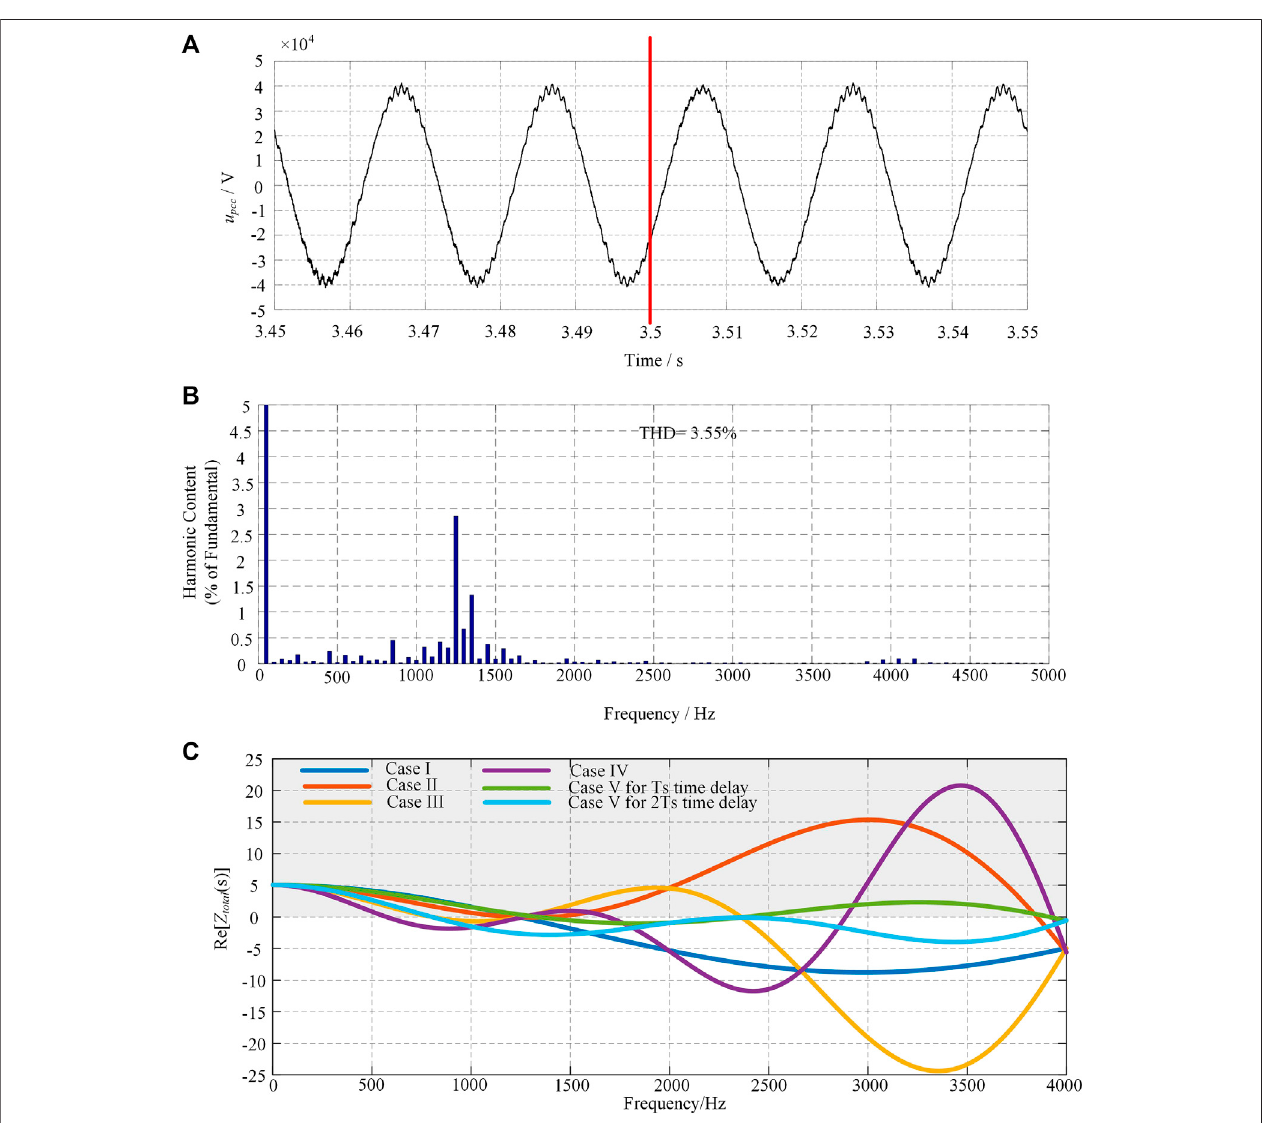
FIGURE 10 | The simulated waveforms and the harmonic spectra for case I (A) voltage of the PCC, (B) harmonic spectra of u PCC , (C) the real part of Case I ∼ V.